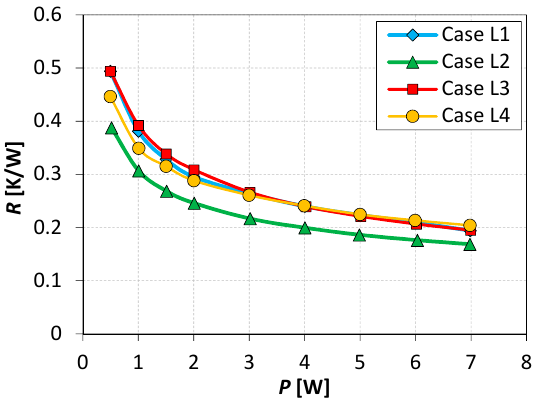
Figure 10. Heat sink thermal resistances as a function of power delivered to the actuator at individual resonance frequency.